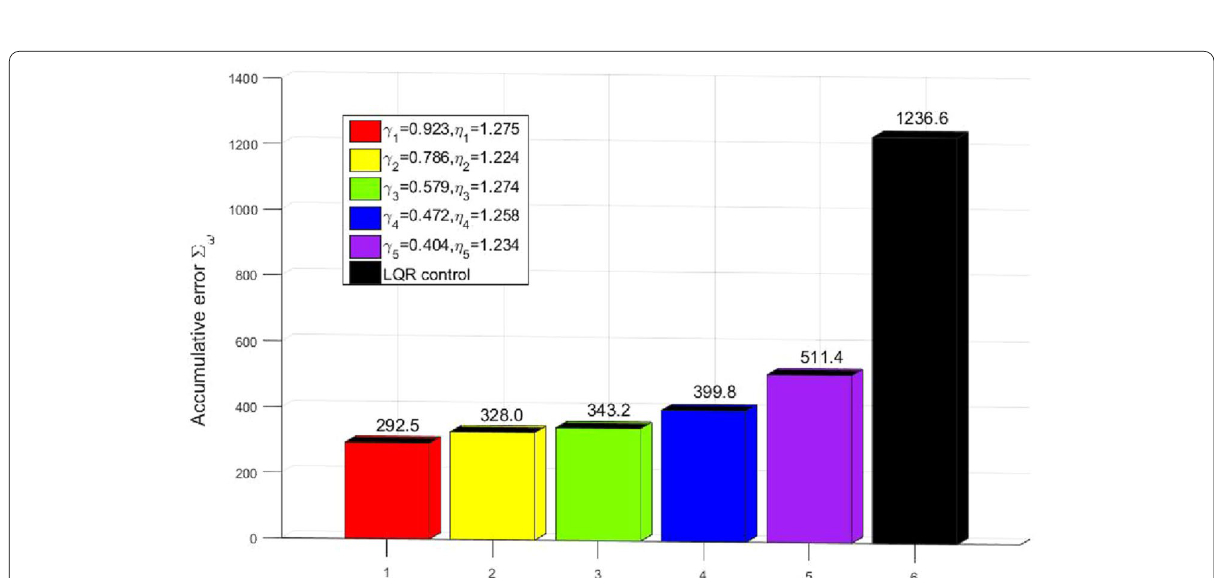
Figure 6 Comparison of accumulative error �